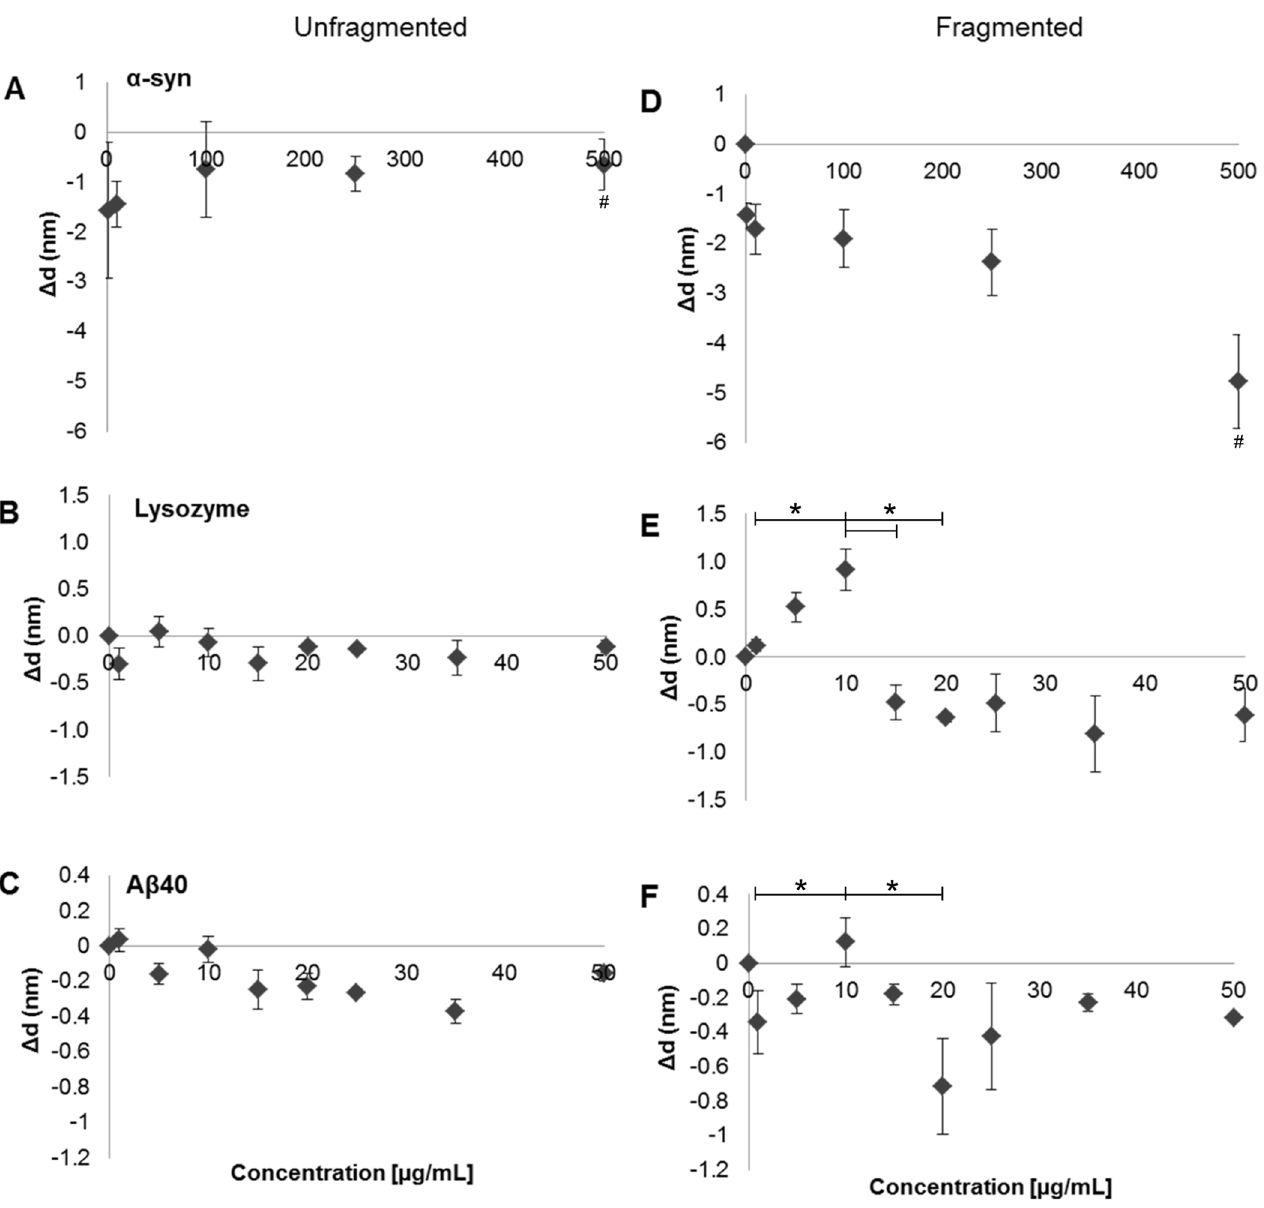
Fig 4. TIRE measurements of membrane disruption at native lipid membrane by the incremental addition of amyloid fibrils. Natively derived cells from the neuronal cell line; SH-SY5Y was deposited by Langmuir-Schaefer deposition and protein: lipid interactions were probed between amyloid fibril samples and plasma membranes. Left plots (A, C and E) show experiments with unfragmented samples and right plots (B, D and F) fragmented samples. Top row plots (A+D) show experiments with α -Syn, middle row (B+E) Lysozyme, and bottom row (C+F) A β 40. Membrane thickness were measured by change in Δ d (nm), which is ploted versus fibril concentration (n = 3, error bars show SE). Statistical significance for the differences in thickness within an experiment on exposure to fragmented fibril samples was determined by Kruskal Wallis test with an Conover-Inman post hoc-test. ( * ) or ( ** ) denote P (cid:1) 0.05 and P (cid:1) 0.005, respectively. Statistical significance between separate unfragmented and fragmented experiments in the case of α -syn was also determined by Kruskal Wallis with an Inman post hoc-test with P (cid:1) 0.05 ( #